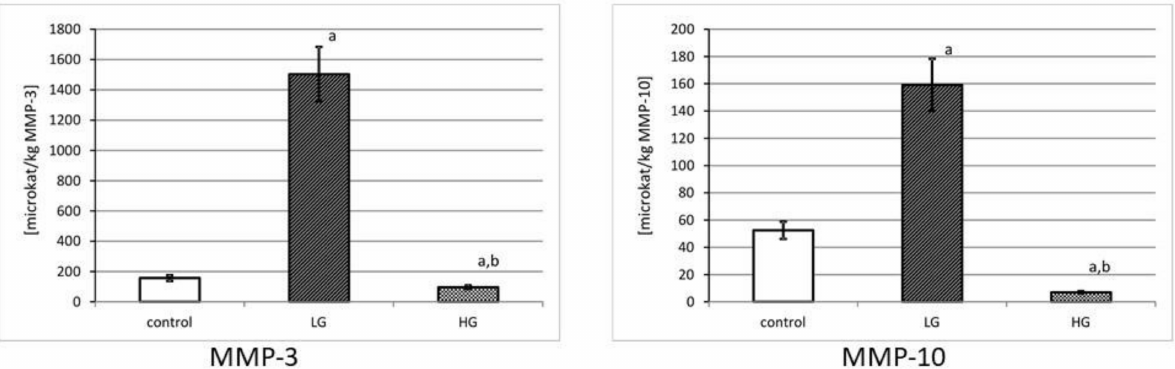
Figure 6. MMP-3 and MMP-10 specific activity in control tissue and low-grade (LG) and high-grade (HG) urinary bladder cancer. a— p < 0.001 cancer vs. urinary bladder control; b— p < 0.001 high-grade vs. low-grade urinary bladder